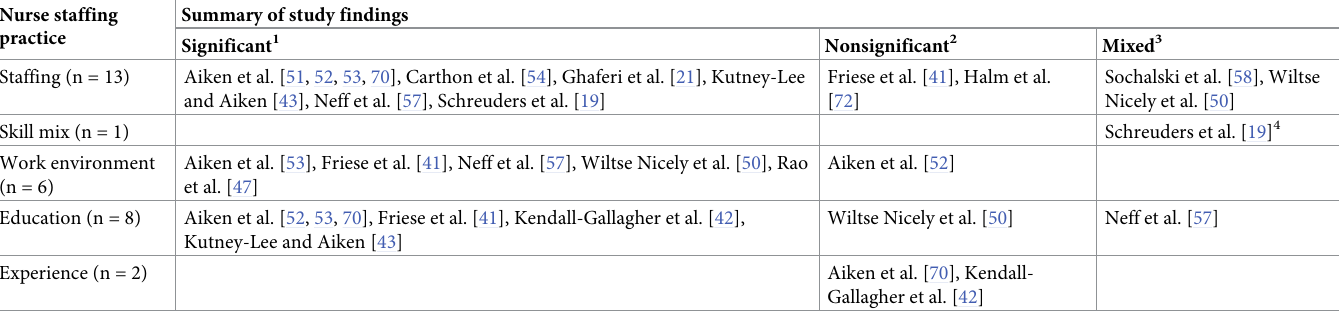
Table 6. Nurse Staffing Practices in Association with 30-Day